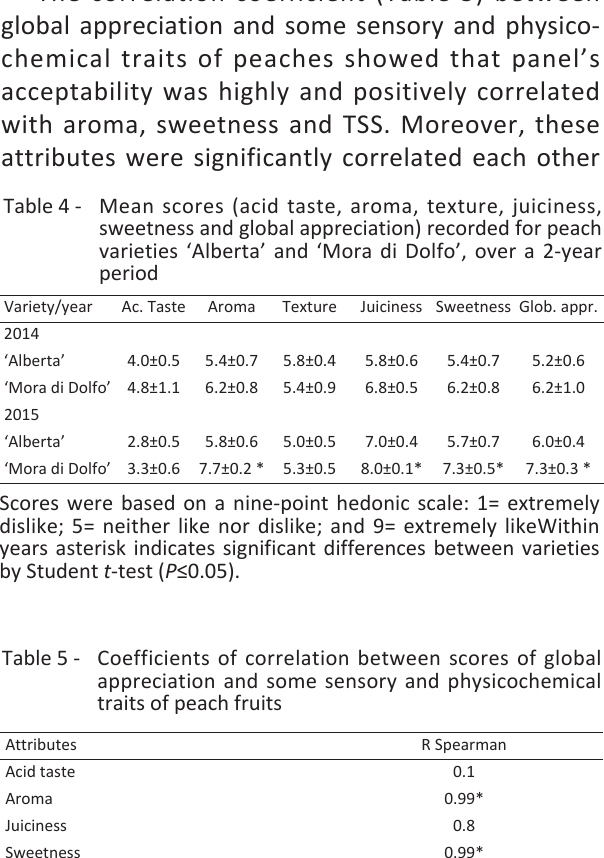
Significant coefficients are denoted by an asterisk at P